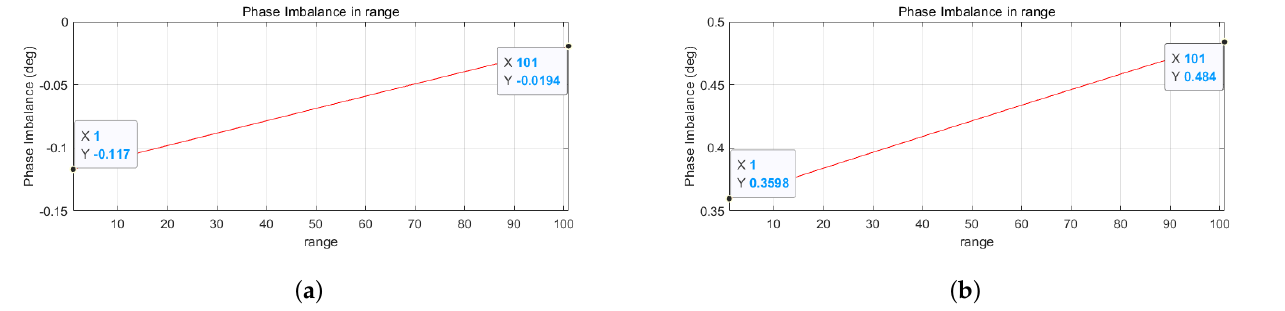
Figure 12. The relative change of phase imbalances in range caused by the attitude error. ( a ) The first set of GF-3 ATI data; ( b ) the second set of GF-3 ATI